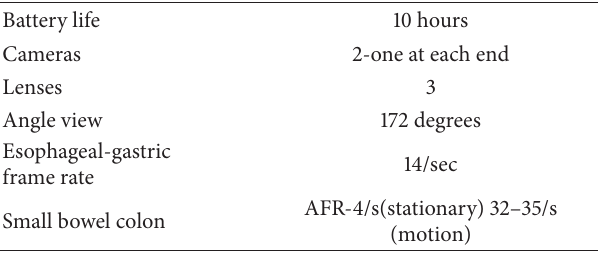
Table 1: PillCam 2 properties.